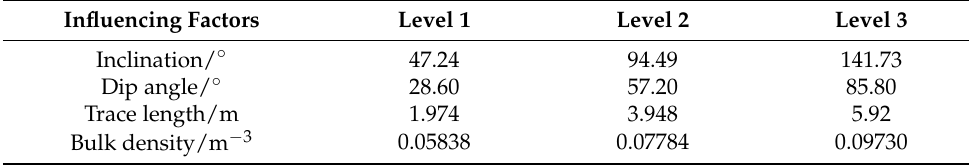
Table 5. Level values of the influencing factors of the Group 2